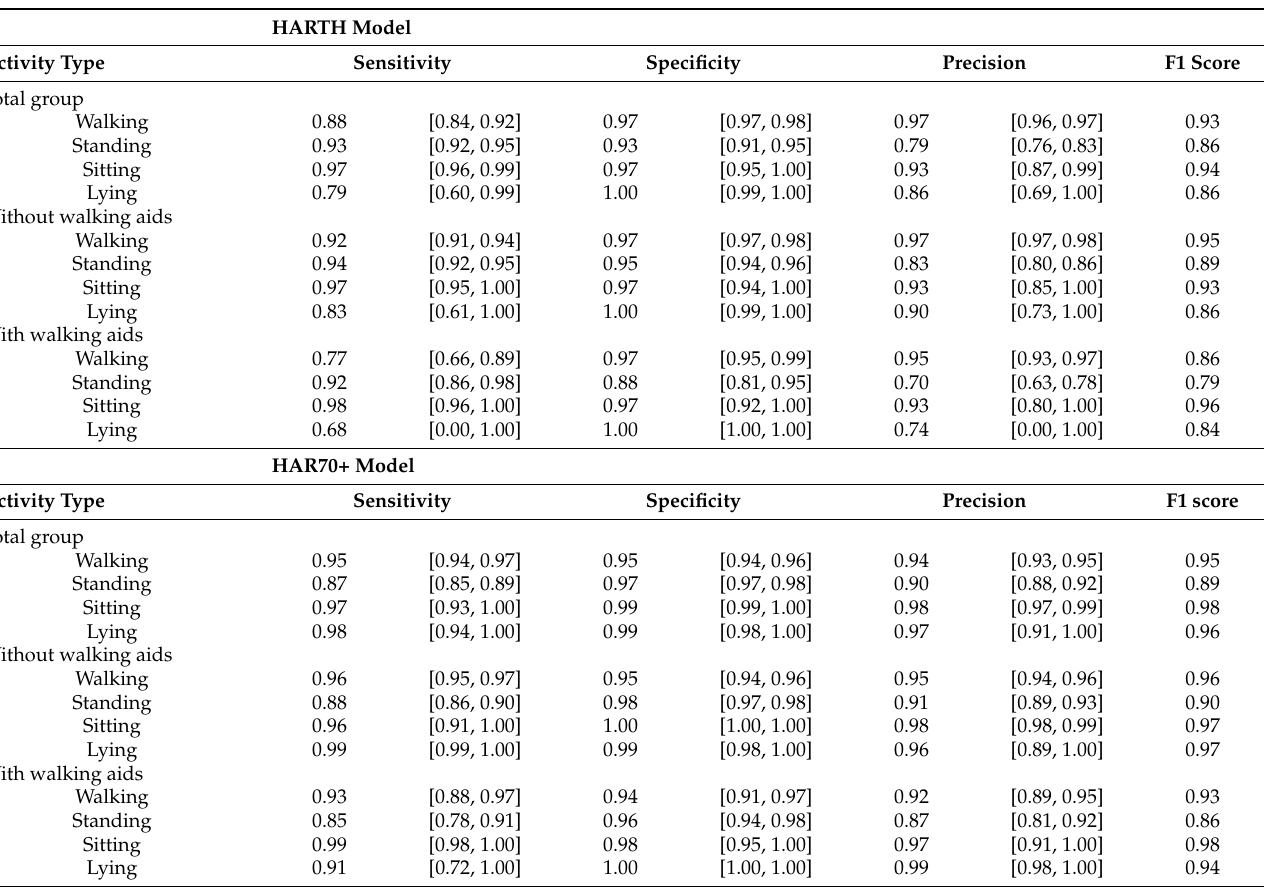
Table 3. Sensitivity, specificity, and precision, calculated as mean [95% confidence interval] across participants, and F1 score, calculated as harmonic mean between sensitivity and precision, for classification of daily physical behavior for the Human Activity Recognition Trondheim (HARTH) model and the Human Activity Recognition 70+ (HAR70+)